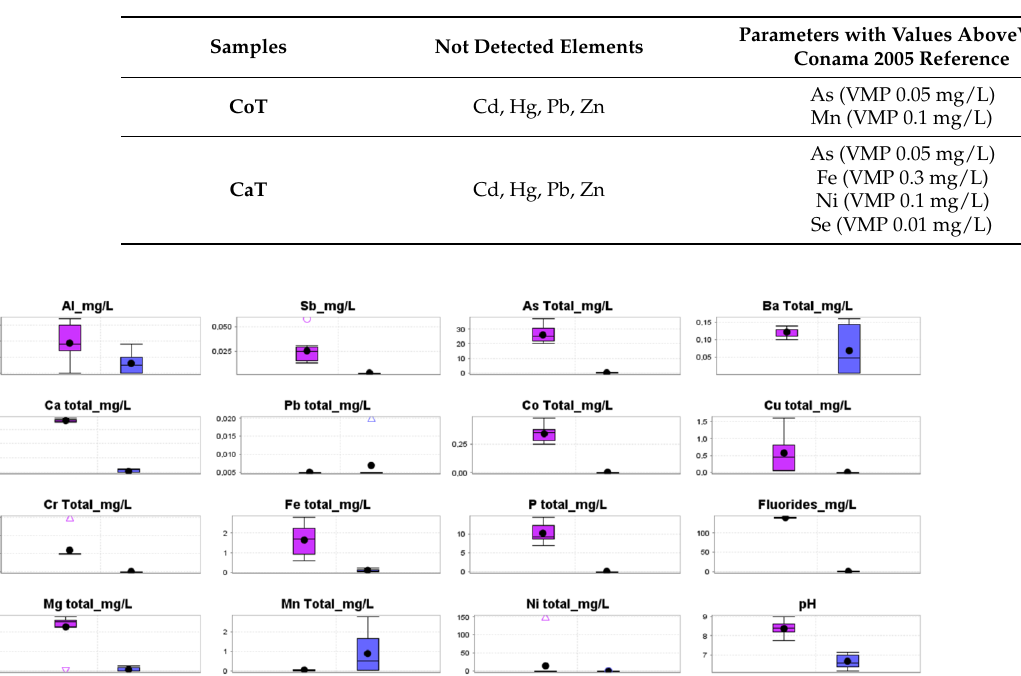
Figure 9. Comparison of the average levels of metals, metalloids, fluorides and pH in SPLP leaching extracts. VMP Al = 0.2 mg/L; VMP Sb = NA; VMP As = 0.05 mg/L; VMP Ba = 1.0 mg/L; VMP Ca = NA; VMP Pb = 0.05 mg/L; VMP Co = NA; VMP Cu = 1.0 mg/L; VMP Cr = 0.05 mg/L; VMP Fe = 0.3 mg/L; VMP P = NA; VMP Fluorides = NA; VMP Mg = NA; VMP Mn = 0.1 mg/L; VMP Ni = 0. 1 mg/L. NA – Not applied for recreation use.